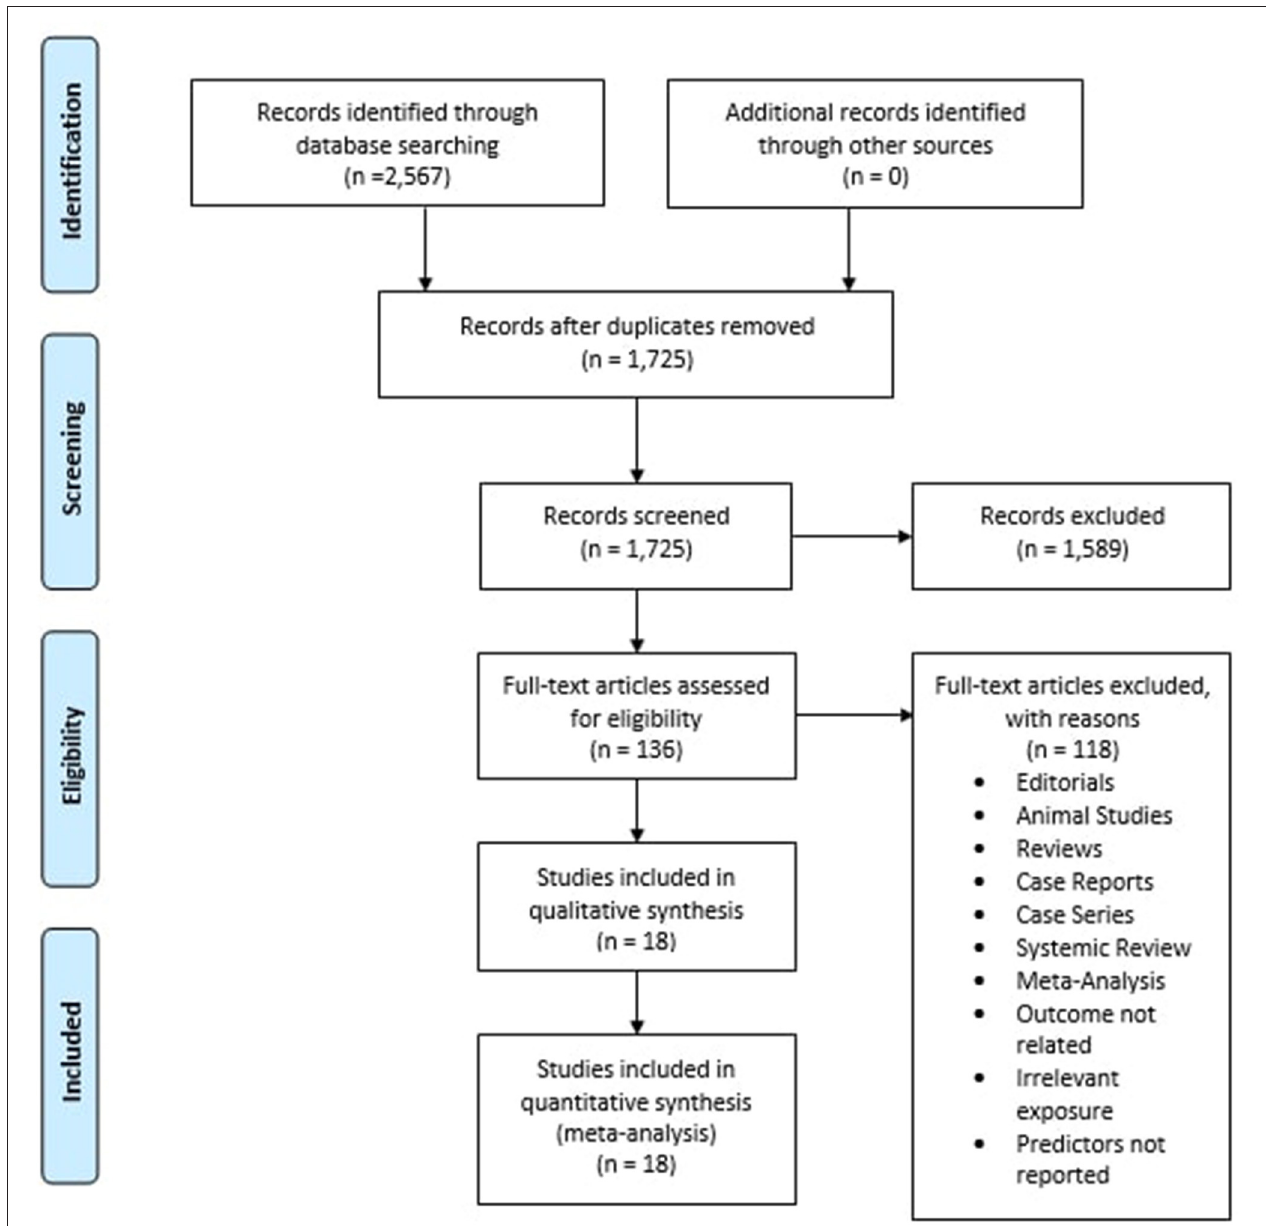
FIGURE 1 | Prisma flow chart summarizing the literature